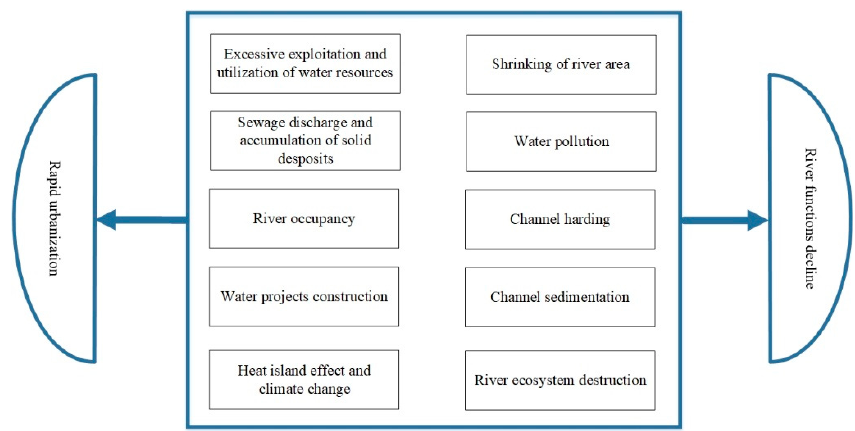
ff ect of urbanization on Figure 4. Effect of urbanization on rivers. Figure 4. E Figure 4. Effect of urbanization on rivers.